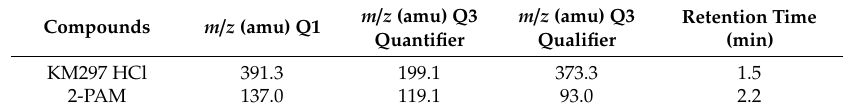
Table 2. Multiple reaction monitoring (MRM) transitions and retention times. amu = atomic mass